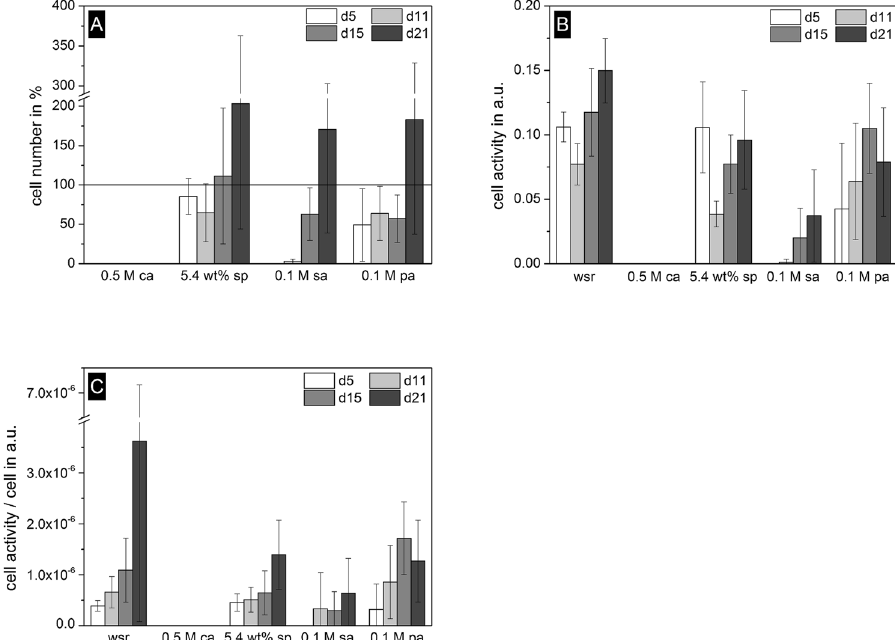
Figure 2. Cell number of RAW 264.7 osteoclasts with regard to cement without setting retardant (solid line at 100%) ( A ), Cell activity ( B ) and cell activity per cell ( C ). Samples without setting retardant (wsr) and retardants citric acid (0.5 M ca), sodium pyrophosphate (5.4 wt% sp), sulfuric acid (0.1 M sa) and phytic acid (0.1 M pa) were cultured over 21